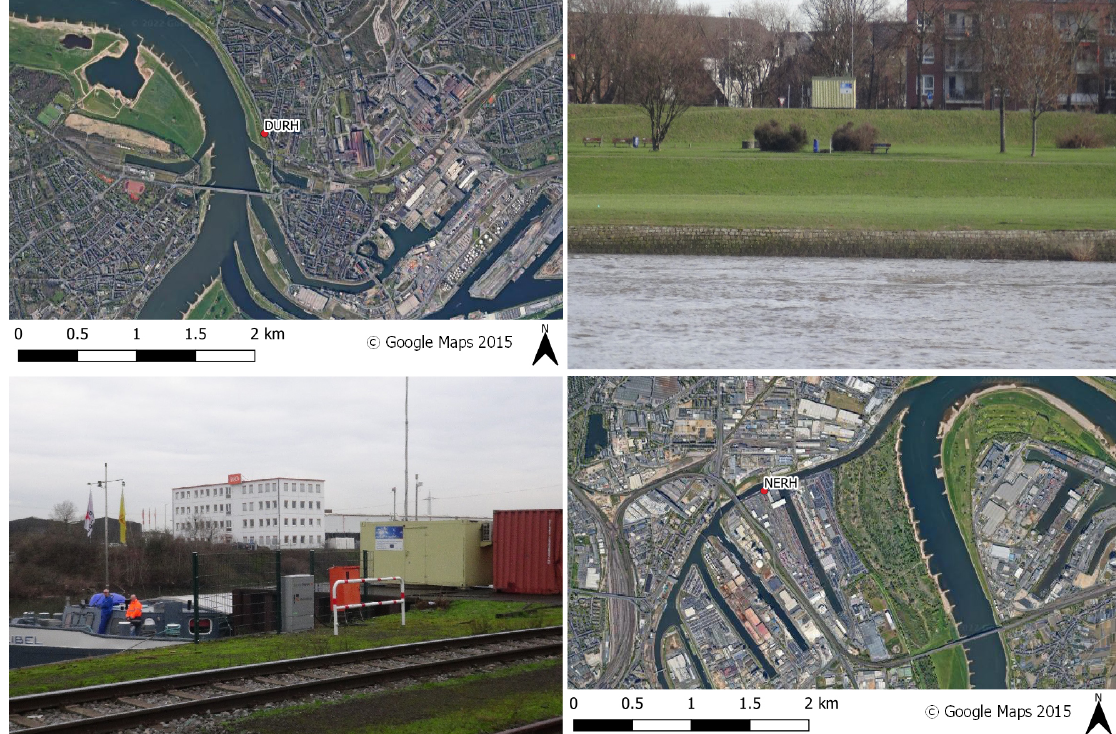
Figure 1. Views of the two different measurement sites used in this study. The upper row shows a satellite image of the DURH station and a picture of the measurement container, as seen from the Rhine. The lower row shows a picture of the measurement container in the NERH and a satellite picture of its